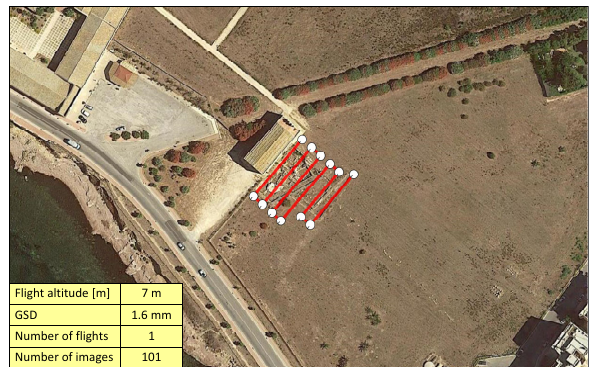
Figure 6. Flight specifications for the archaeological area of “San Giovanni”.